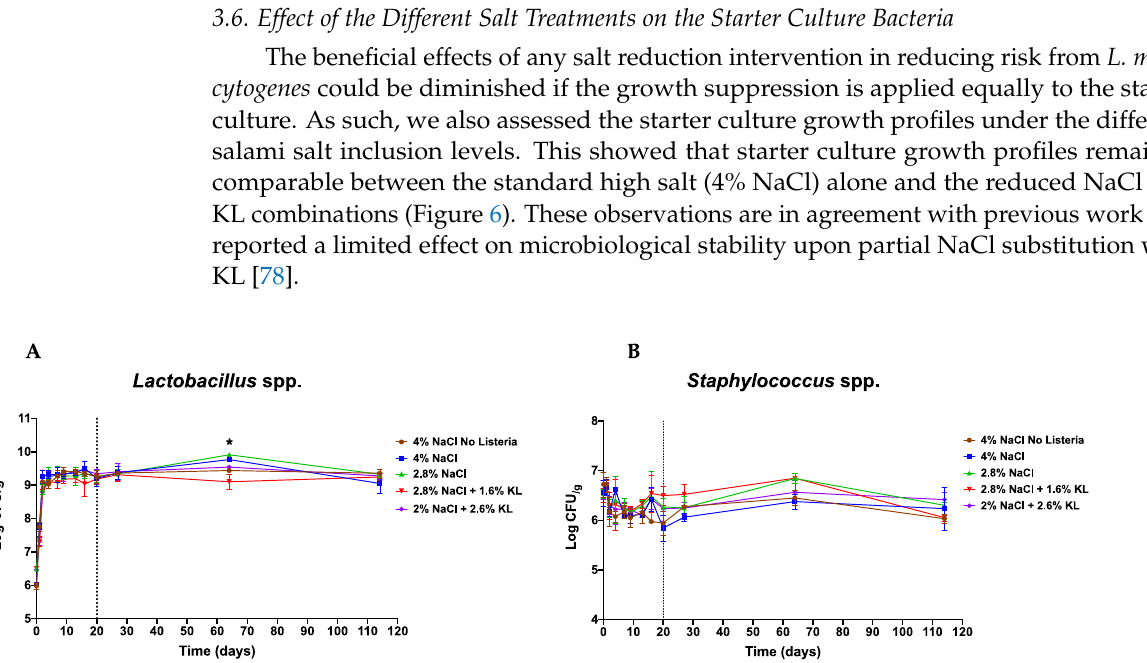
Figure 6. Growth profiles of ( A ) Lactobacillus plantarum and ( B ) Staphylococcus xylosus during salami ripening and storage. The starter culture bacterial growth profiles were comparable between the different salami batches. Shown are mean log CFU numbers from two experimental repeats observed on 0, 1, 2, 4, 7, 9, 13, 16, and 20 days of salami ripening. Day 27, 64, and 114 represent 7, 44, and 94 days of storage at 4 °C. The dotted line denotes the end of salami ripening. * Indicates significant difference between salami batches ( p < 0.05 based on one-way ANOVA and Tukey post-hoc test pairwise comparison of the salami batches).